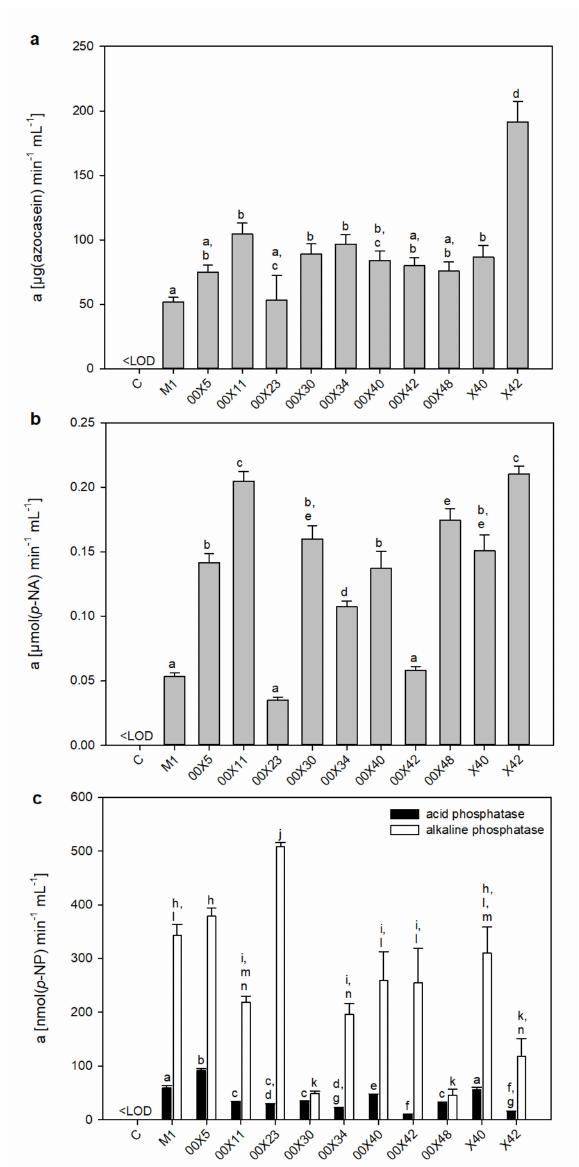
Figure 5. Activities of proteases and phosphatases secreted into the medium by Pythium strains. Total proteolytic activity ( a ), serine proteases ( b ), acid and alkaline phosphatases ( c ). Each code (00X5, 00X11, 00X23, 00X30, 00X34, 00X40, 00X42, 00X48, X40, X42, and M1) represents a Pythium strain. Control